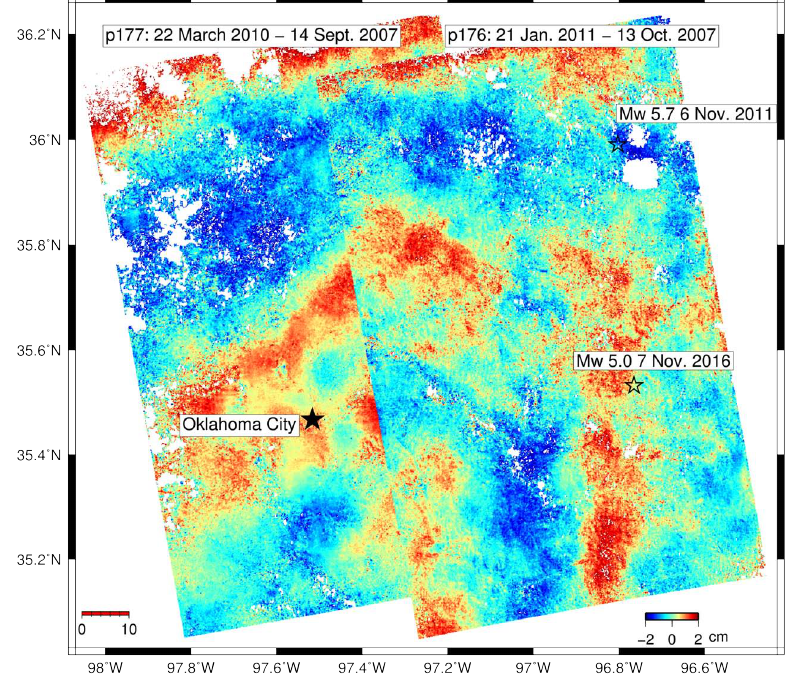
Figure 15. Two interferograms from overlapping paths from the ALOS-1 satellite (dates above each path) in a region in Oklahoma (Oklahoma City is labeled) with numerous wastewater injection wells and earthquakes that do not show clear ground deformation (detection threshold is > 3 cm/yr based on studies cited in the text). The locations of earthquakes with magnitudes > 5 (from the USGS) that occurred after the interferogram time spans are